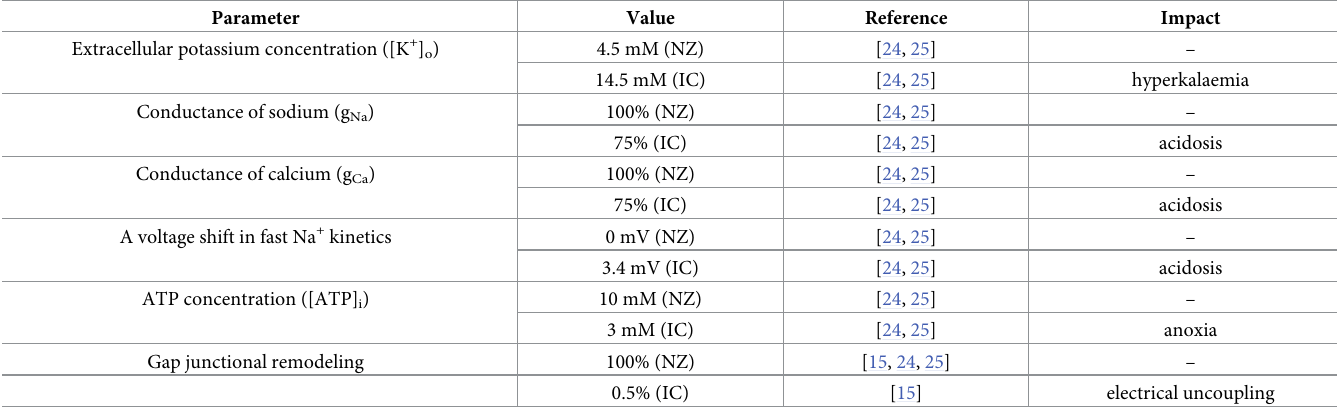
Table 2. Electrophysiological parameter changes during myocardial